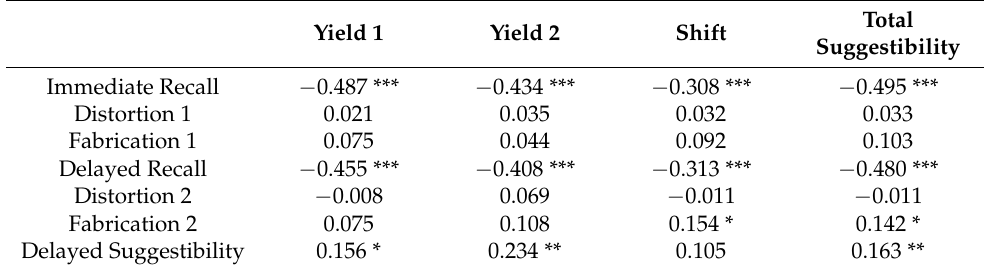
Table A2. Pearson’s correlations between GSS2 scores ( n =